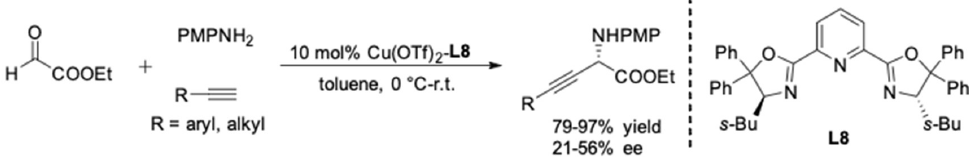
Figure 10. Cu(II)/ s -Bu-pybox-diPh-catalyzed AA 3 -couplings.